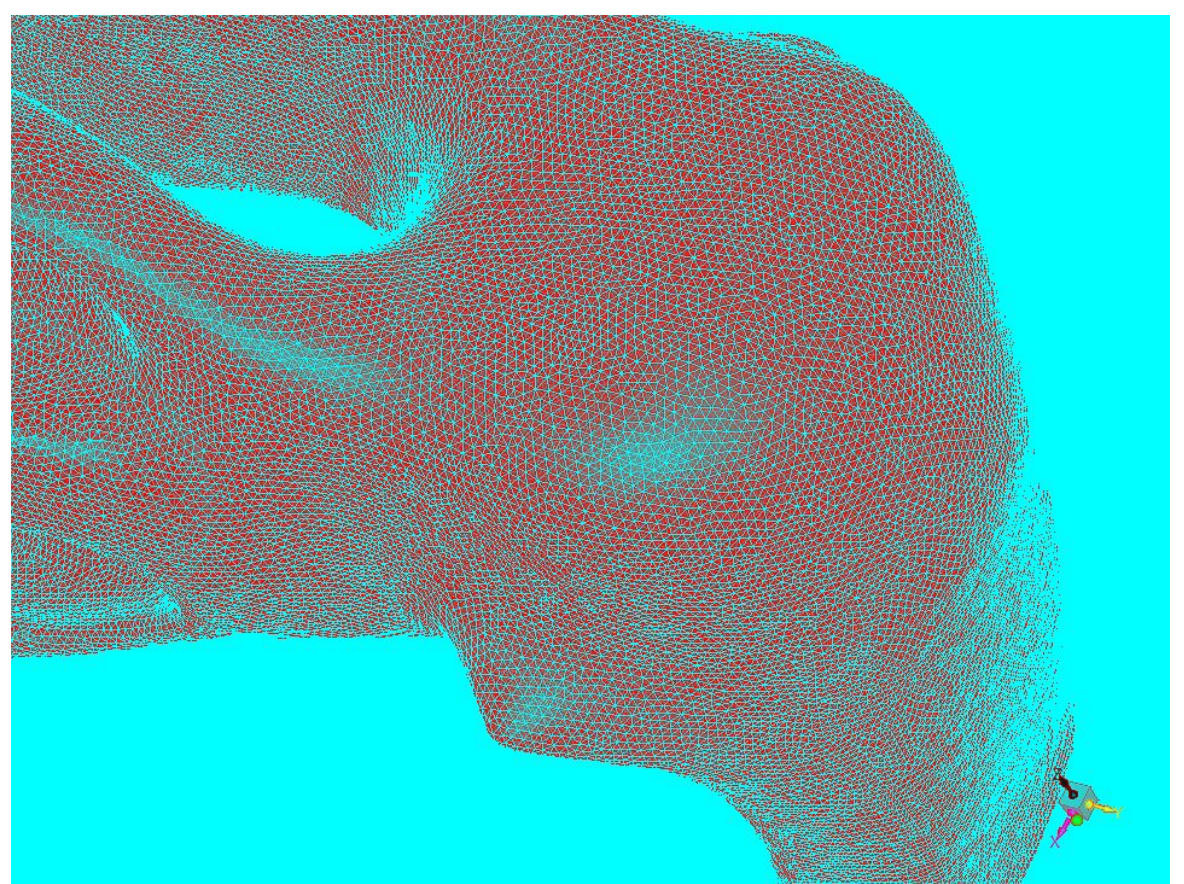
Figure 3. Computational network of a 3D model.